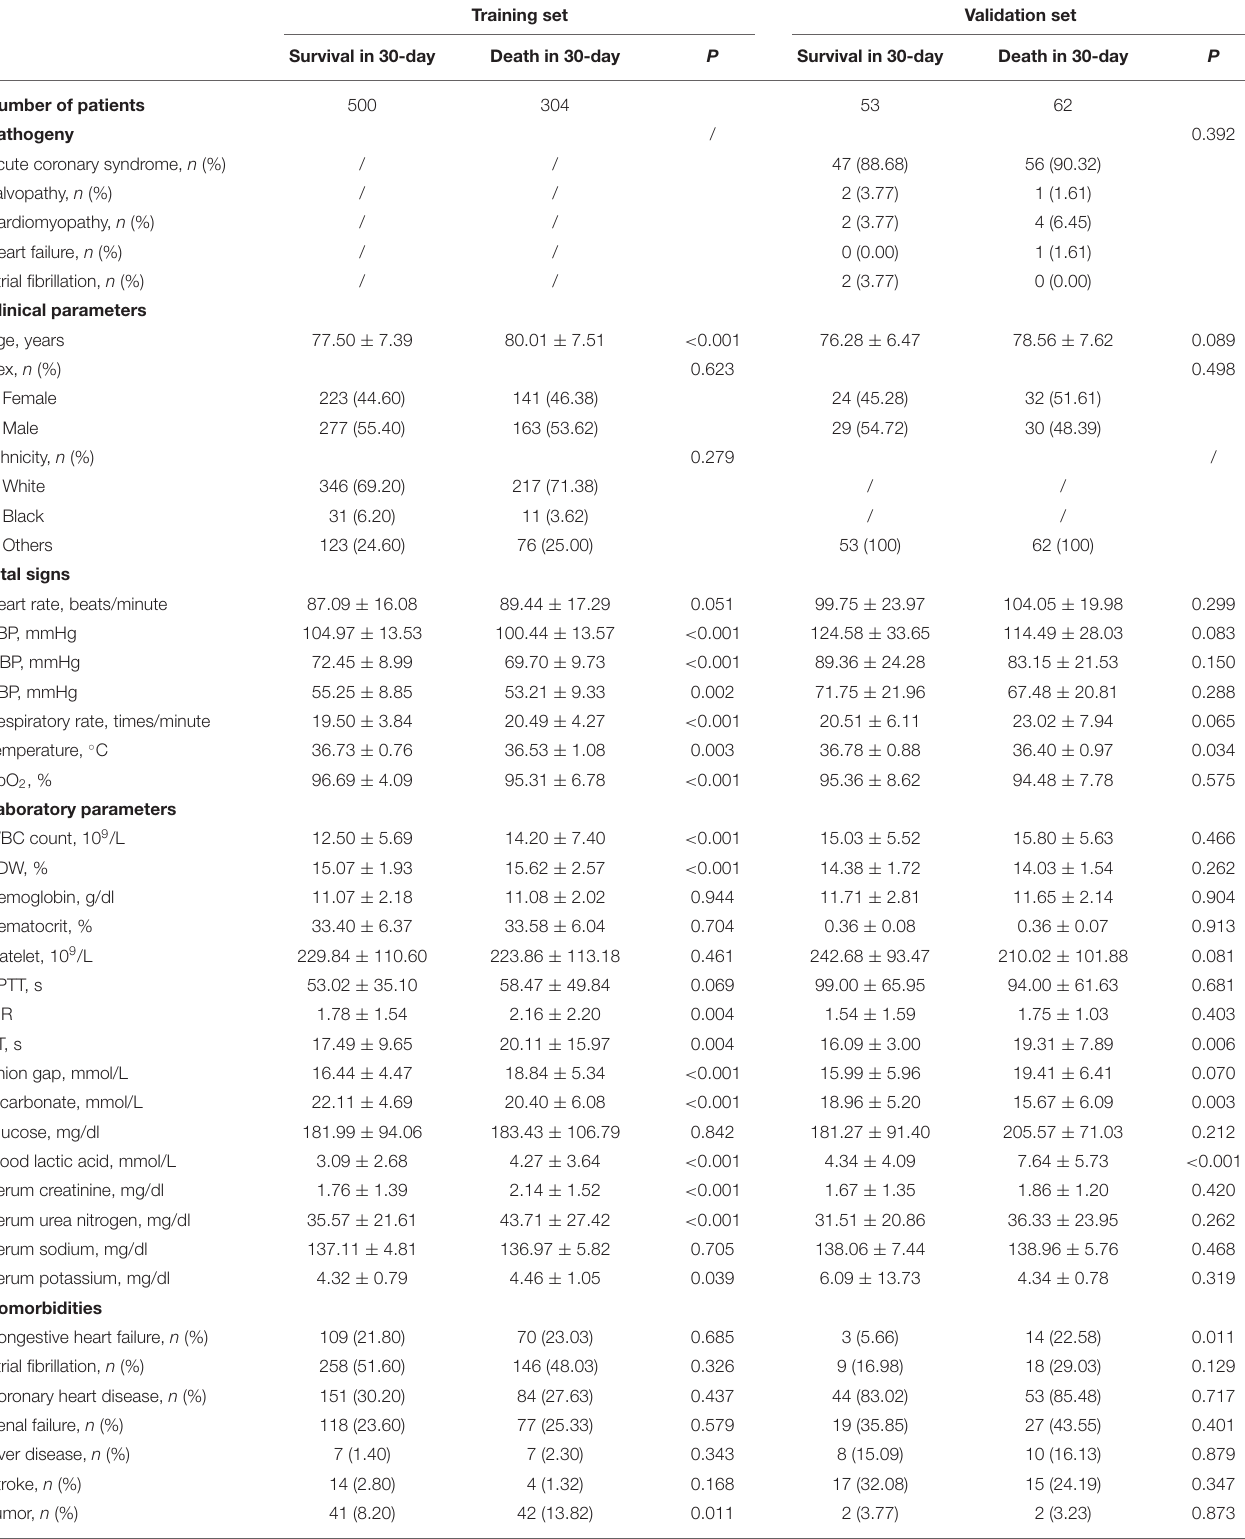
TABLE 1 | Baseline characteristics of the study population of 30-day all-cause death. Training set Validation set Survival in 30-day Death in 30-day P Survival in 30-day Death in